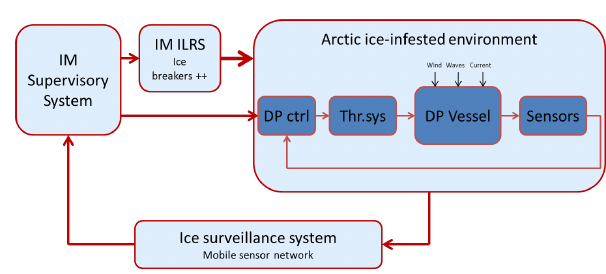
Figure 30: A DP system is placed in an Arctic ice- infested environment. The Ice Management (IM) Ice Load Reduction System (ILRS) use icebreakers as actuation devices to man- age the ice environment and reduce the ice